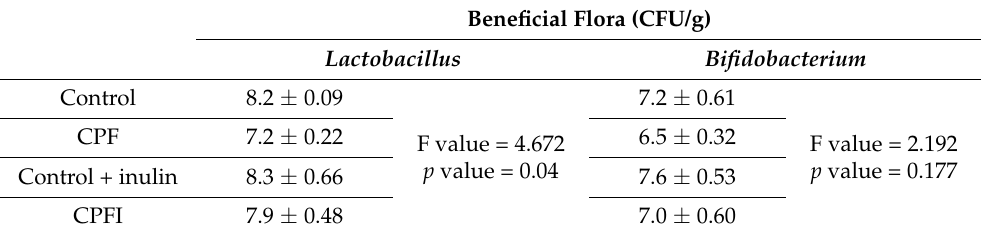
Table 3. Effects of exposure to CPF and inulin on beneficial flora in dams. The values are expressed as mean ± SEM ( n = 4). Significantly different ( p < 0.05) using analysis of variance (ANOVA) and Tukey’s test. C: Control; CPF: Chlorpyrifos; CI: Control inulin; CPFI: Chlorpyrifos + inulin.